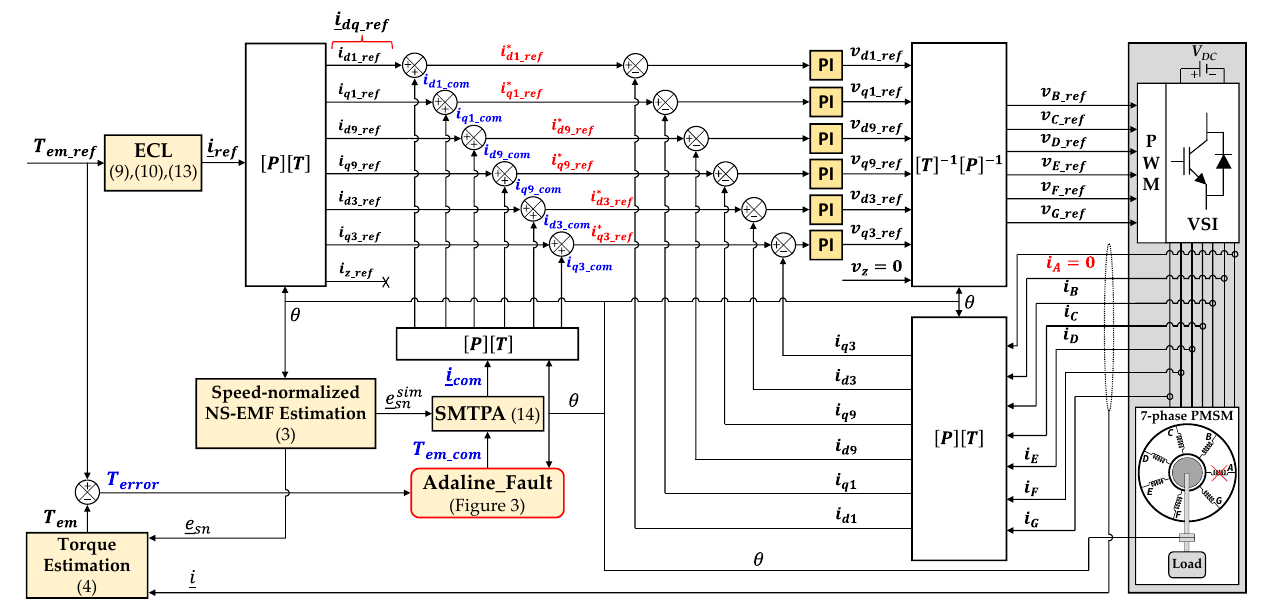
Figure 2. Torque control with the proposed control scheme using Adaline_Fault and ECL strategy for a seven-phase PMSM when phase A is opened.